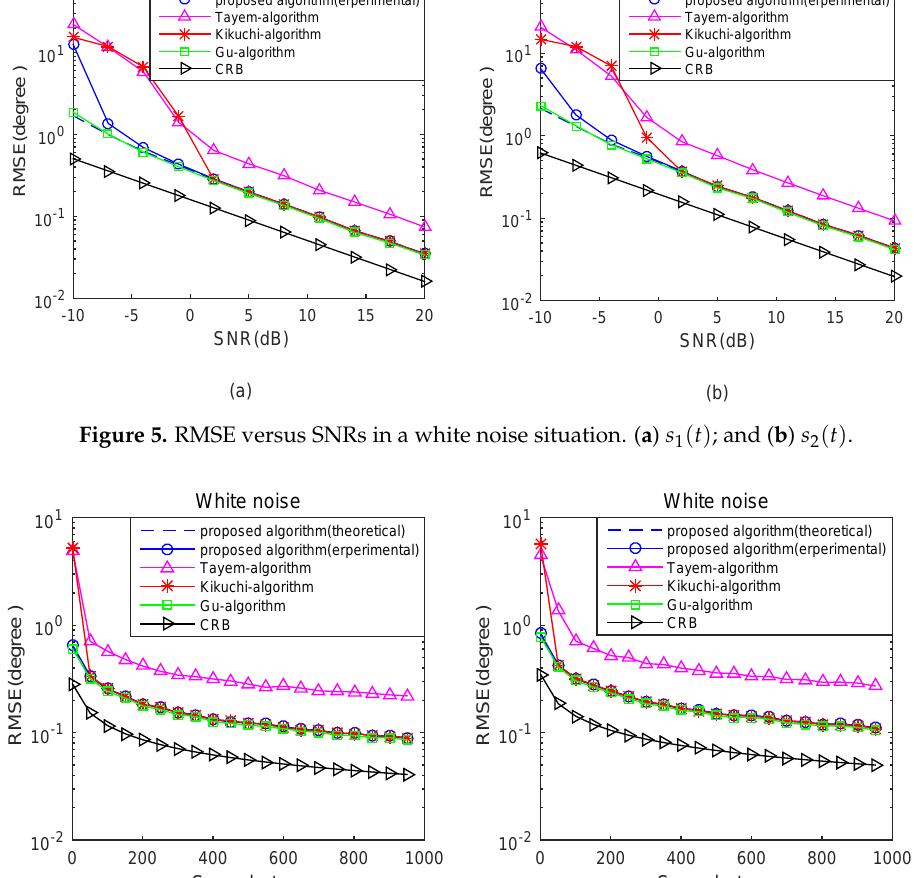
proposed algorithm(theoretical) proposed algorithm(erperimental) Tayem-algorithm Kikuchi-algorithm